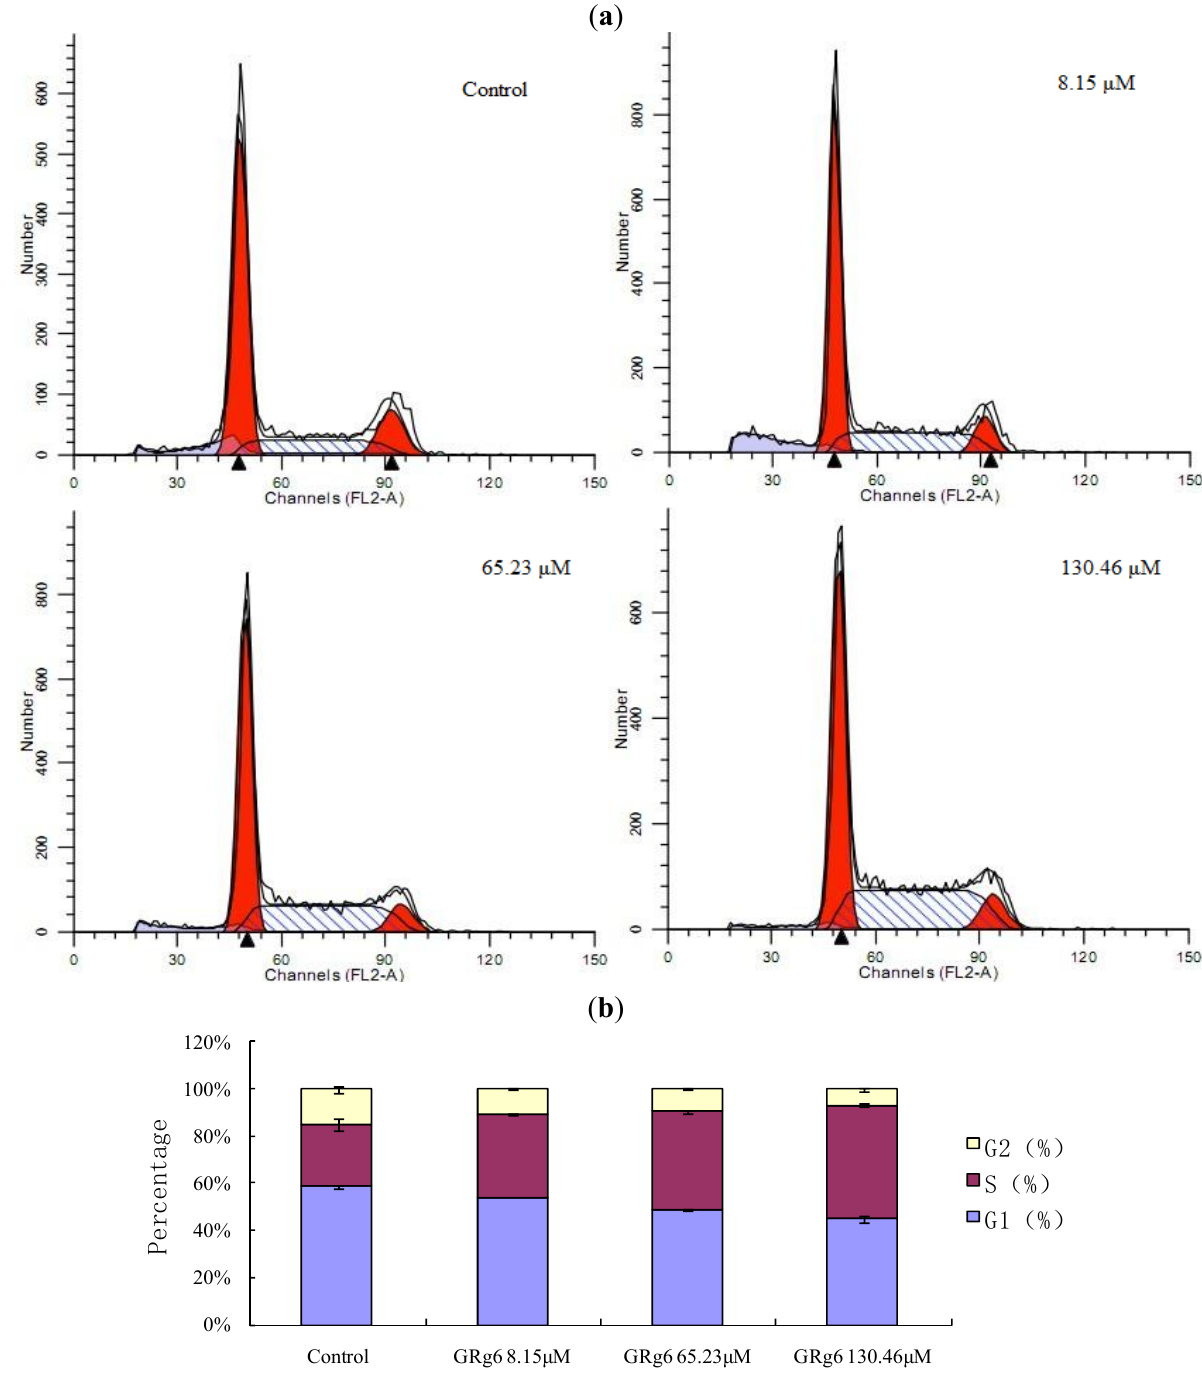
Figure 5. ( a ) Measurement of the cell cycle by PI single-staining analysis. ( b ) Comparison of the cell cycle with different concentrations of